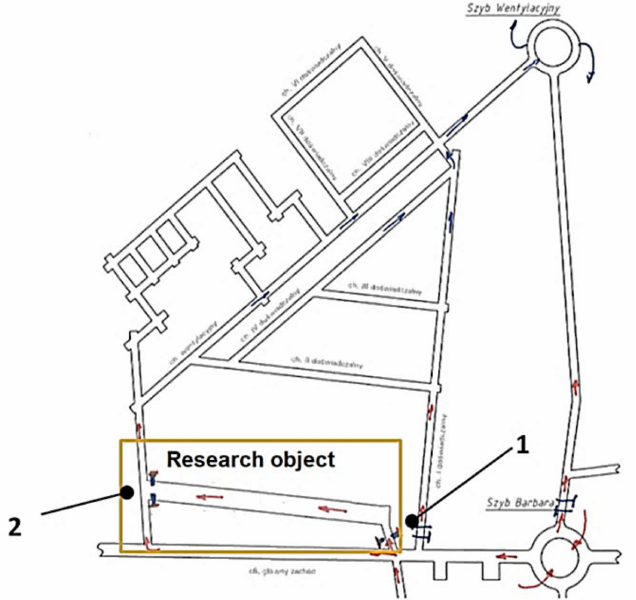
Figure 1. Location of the excavation in the ventilation network of the Experimental Mine Barbara: 1—dam T 2 , 2—dam T 3